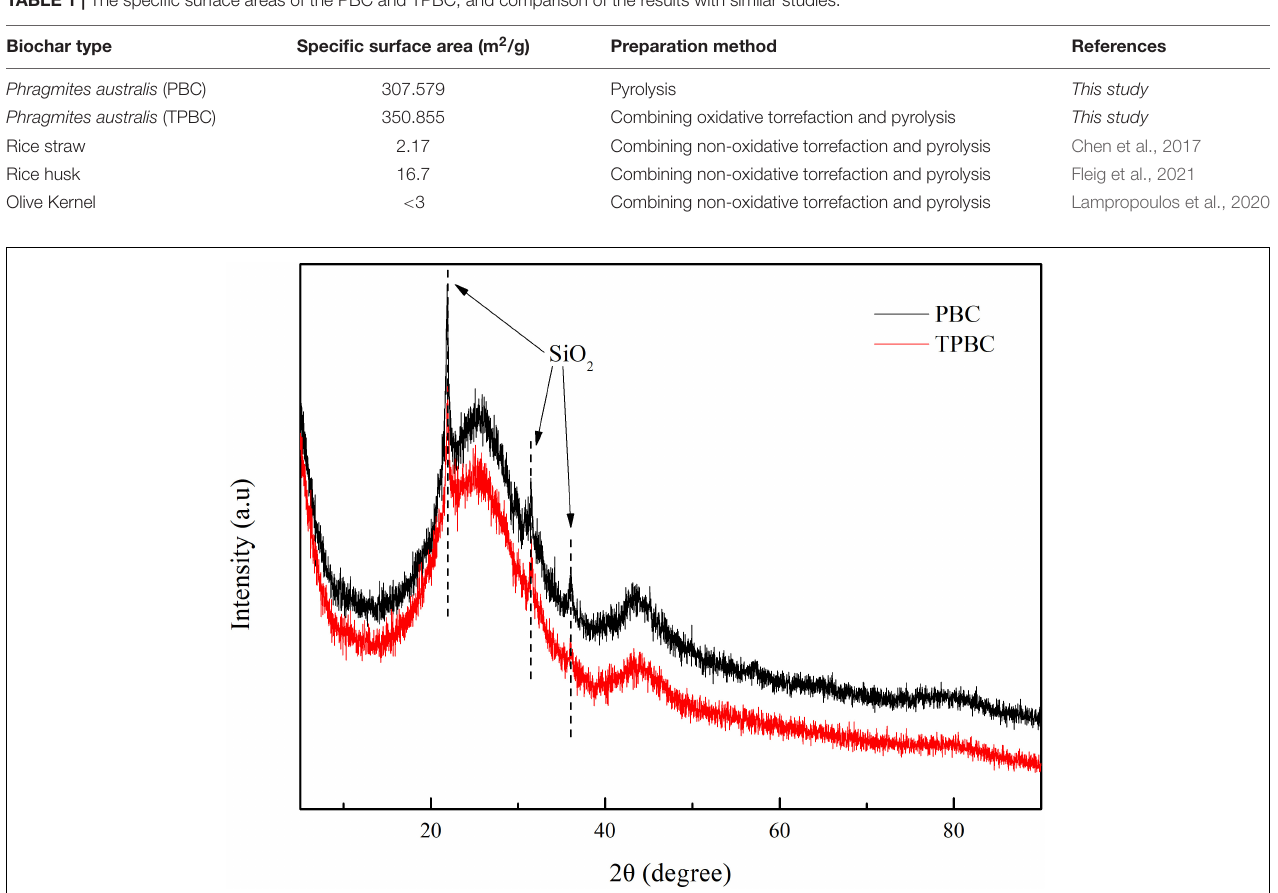
FIGURE 1 | The XRD pattern of the